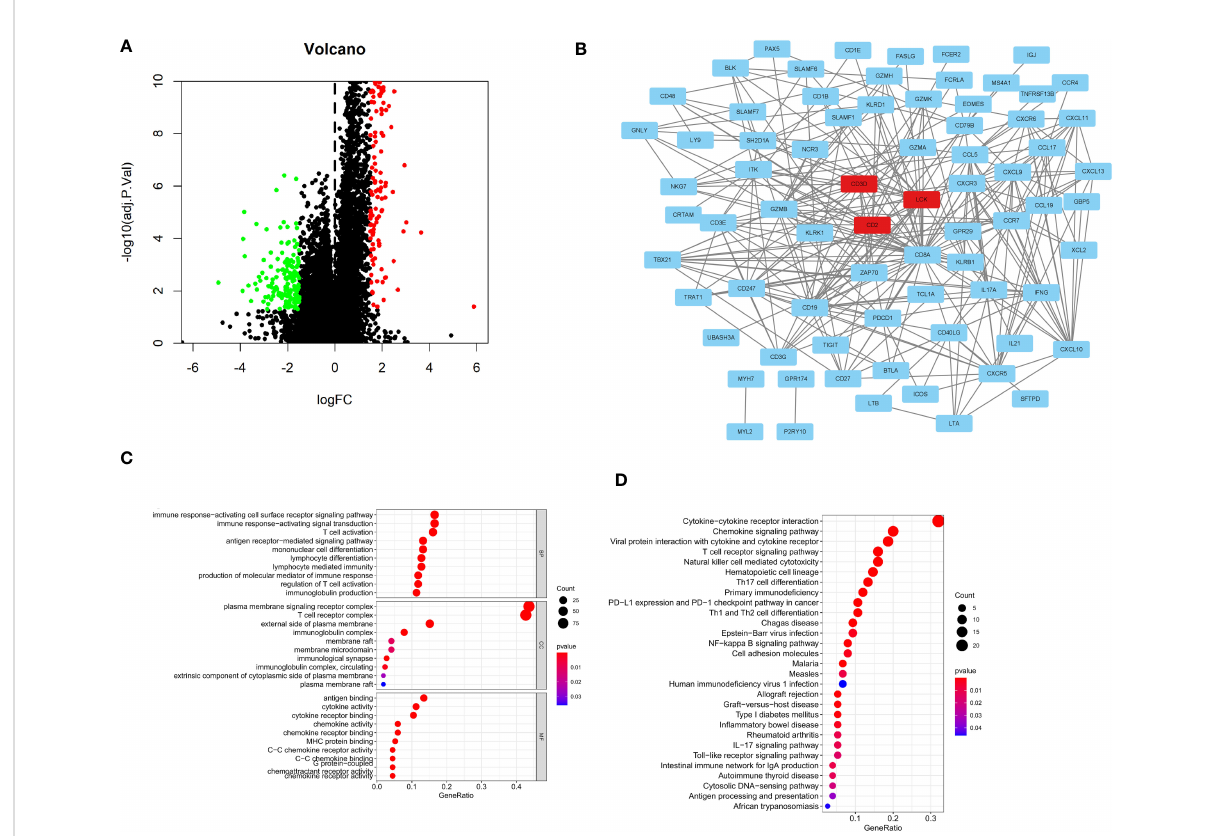
FIGURE 7 Construction of the PPI network and identi fi cation of Hub genes. (A) The volcano plots depicting immune-related DEGs; (B) PPI network displaying the association with 74 DEGs; (C) GO analysis showing enriched GO term; (D) KEGG pathway enrichment